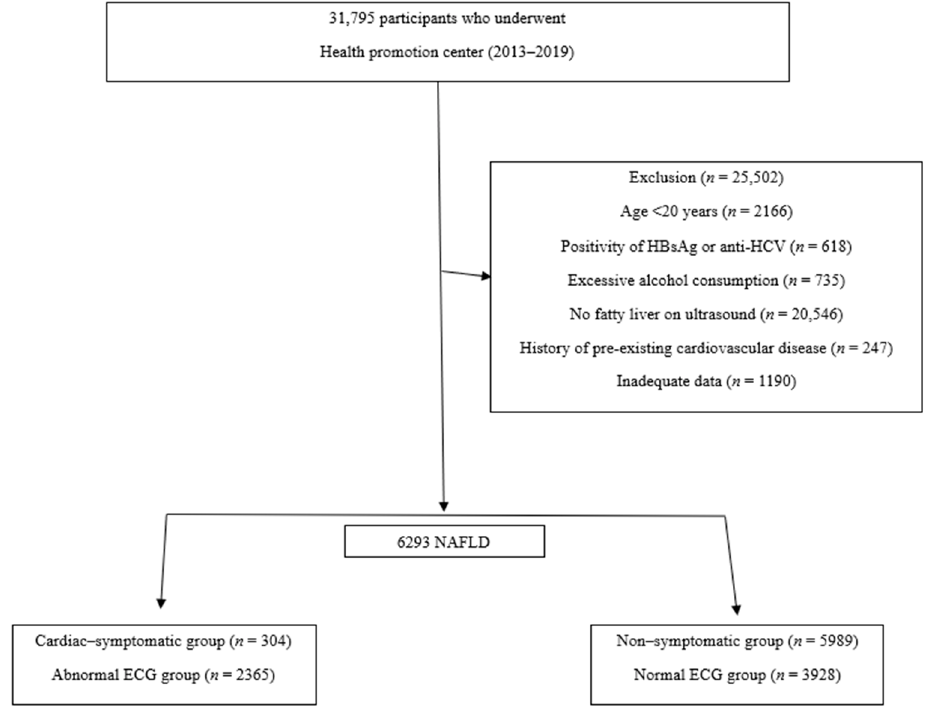
Figure 1. Flowchart of the enrolled